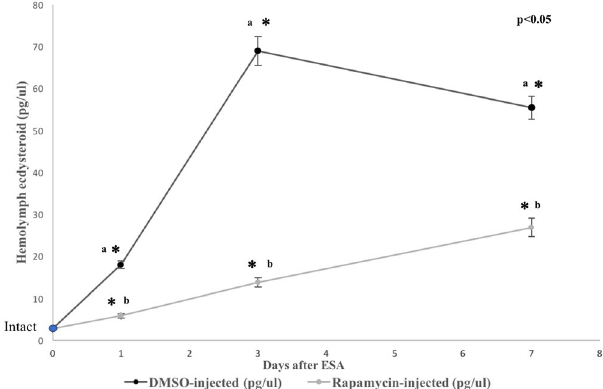
Figure 4. Hemolymph ecdysteroid titers prior and subsequent to ESA for DMSO- and rapamycin-injected animals. Intact (Intermolt) level represents the Day 0 reading (marked as the blue circle). The X axis represents days after ESA. Asterisks ( * ) represent significant differences between DMSO- and rapamycin-injected animals for each time point. Small letters represent significant differences within treatments between time points (a = DMSO-injected; b =